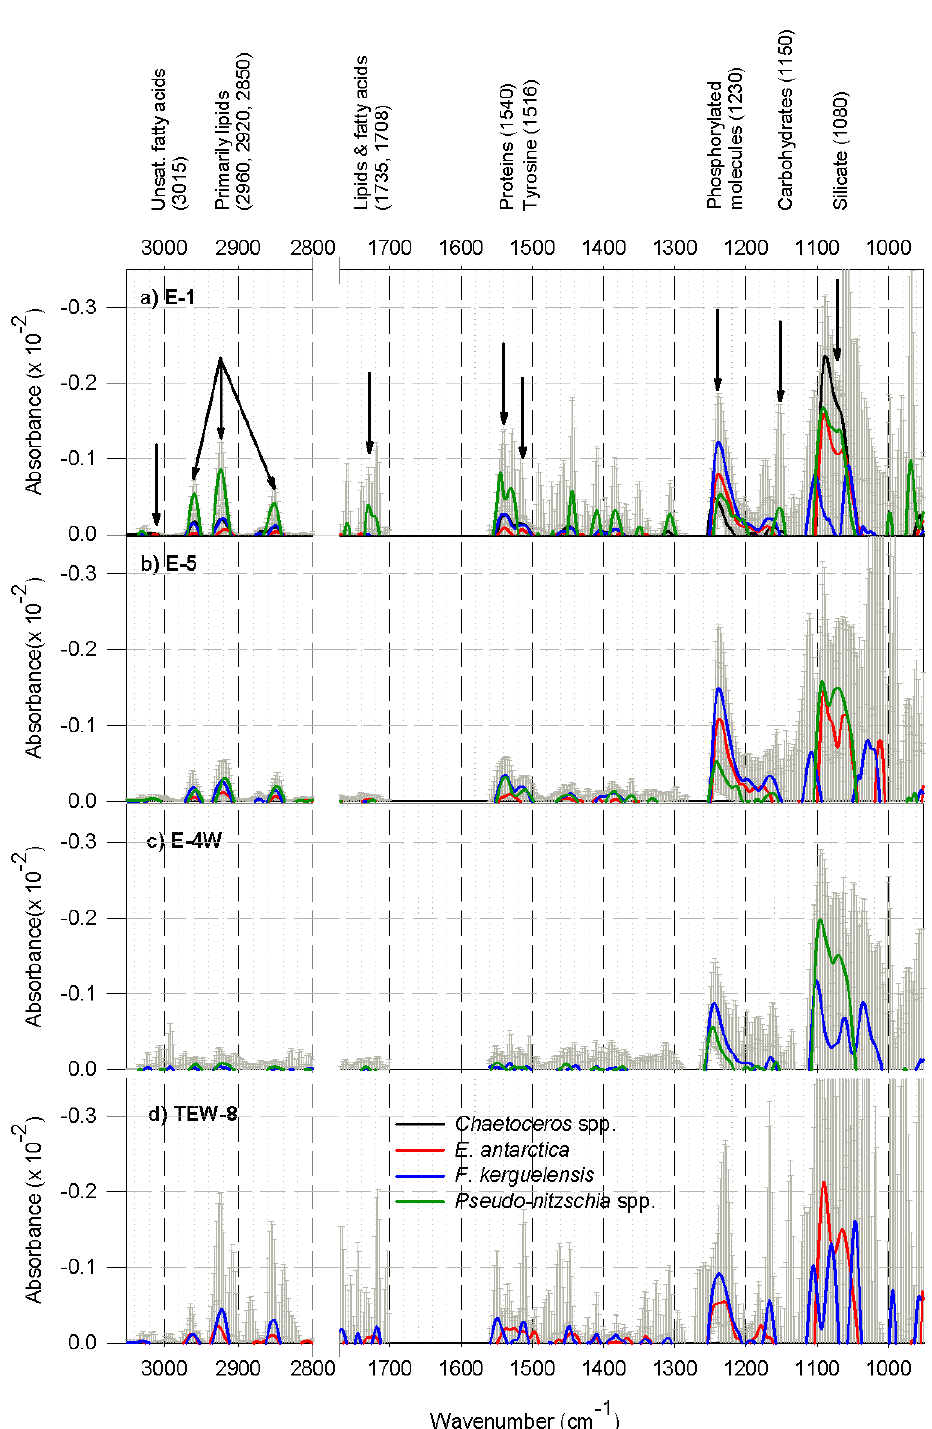
Figure 2. Average second-derivative cell spectra from four common genera: Chaetoceros, Eucampia, Fragilariopsis and Pseudo-nitzschia . Taxonomic abundance varied between stations hence there are no data for Chaetoceros spp. and Eucampia antarctica at station E-4W, or Chaetoceros spp. and Pseudo-nitzschia spp. at station TEW-8. Panels (a–d) show four different stations. Peaks show the macromolecular composition of cells which is dominated by phosphorylated molecules (1240cm − 1 ) , carbohydrates ( ∼ 1150cm − 1 ) and silicate/silicic acid (1080cm − 1 ) . Peaks found in the spectral region 3050–2800cm − 1 , ∼ 1735cm − 1 and ∼ 1450cm − 1 indicate the presence of lipids. Addi- tionally, peaks at 1540 and 1515cm − 1 indicate the presence of proteins and the amino acid tyrosine, respectively. Error bars indicate one standard deviation from the mean. Note: the y -axis has been reversed to ease examination of the negative peaks (which are the relevant peaks after second-derivative